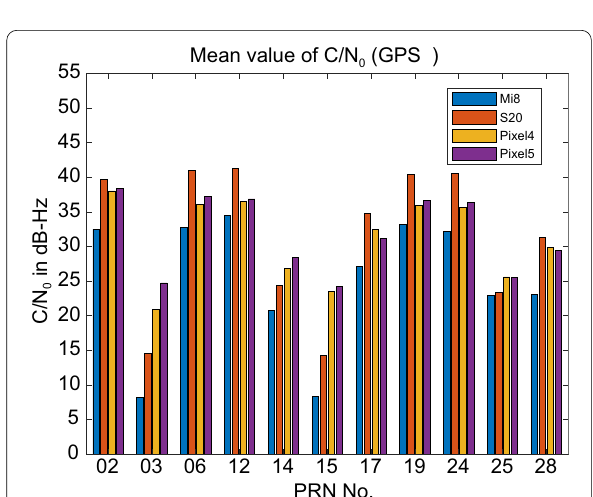
Fig. 4 Mean value of C/N 0 for all GPS